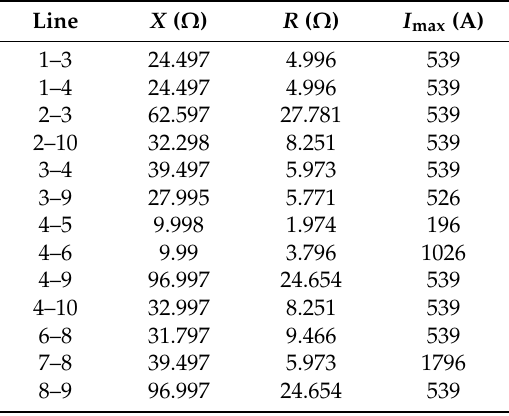
Table 1. CGTN transmission line parameters.